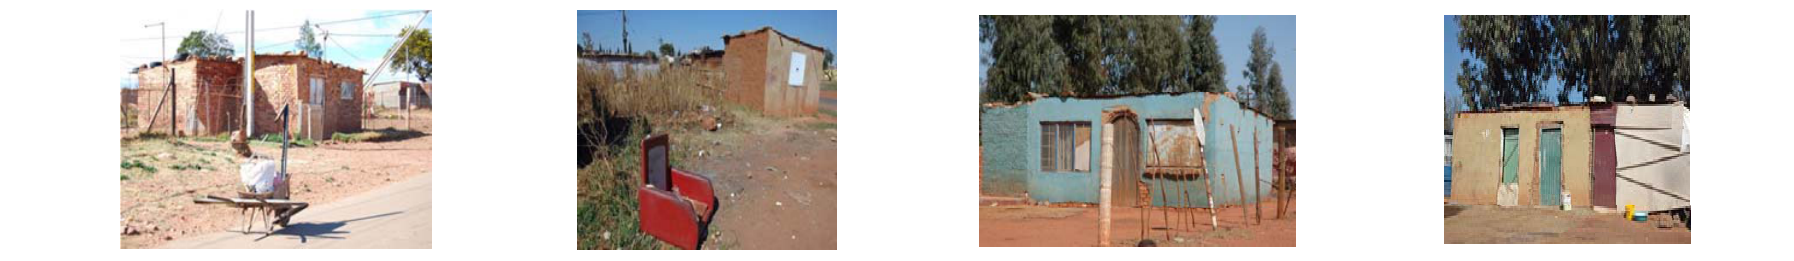
Table 1. Description of the study sites and housing types.